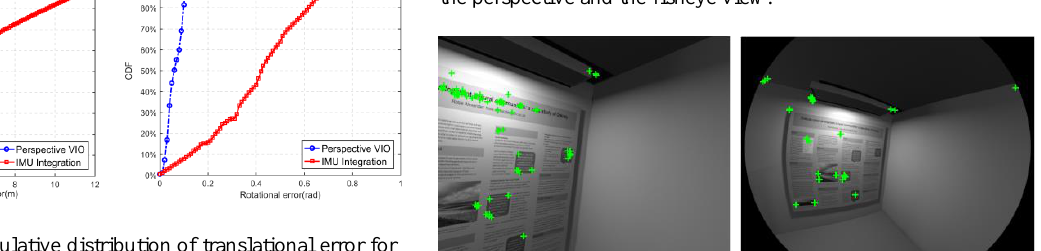
Figure 4. Left : Cumulative distribution of translational error for the perspective VIO approach and the IMU integration. Right : Cumulative distribution of rotational error for the perspective VIO approach and IMU integration.